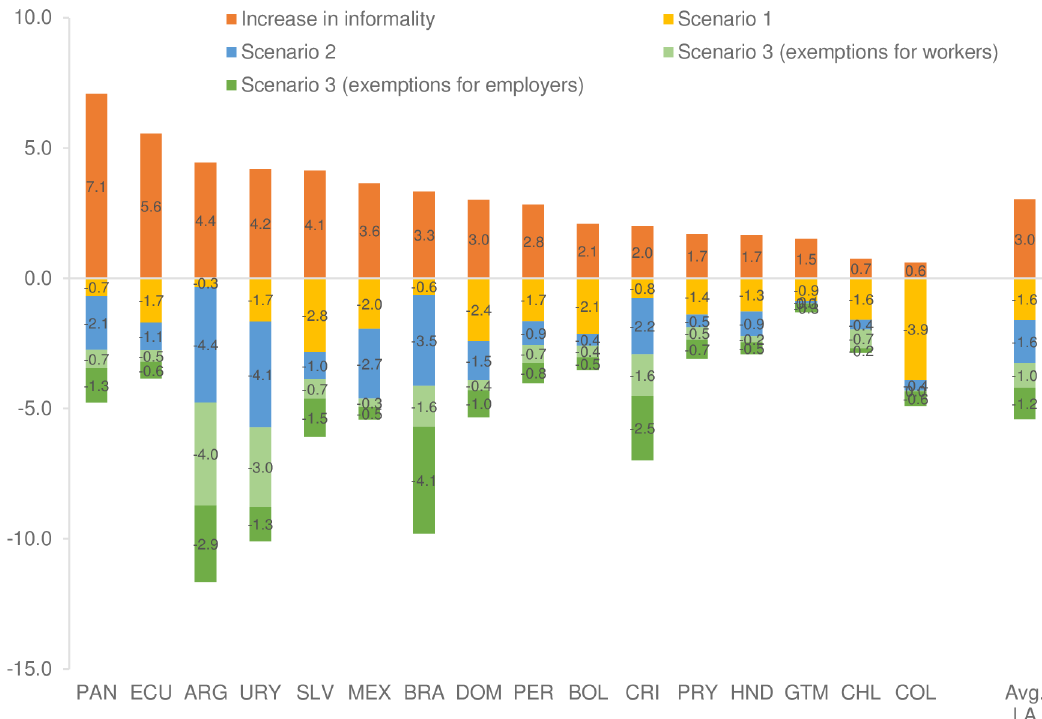
Fig 7. Latin America: Results of the simulation of interventions to cushion impacts on the increase in the informality rate (percentage points). Source: Estimates from household or employment surveys: Argentina—EPH (2019), Bolivia—ECH (2018), Brazil—PNADC (2018), Chile—CASEN (2017), Colombia—GEIH (2018), Costa Rica—ENAHO (2018), Ecuador—ENEMDU (2018), El Salvador—EHPM (2019), Guatemala—ENEI (2018), Honduras—EPHPM—(2018), Mexico—ENIGH (2018), Panama— EPM (2017), Paraguay—EPHC (2018), Peru—ENAHO (2018), Dominican Republic—ENCFT (2017), Uruguay—ECH (2019). p.p.: percentage points. The EPH survey in Argentina only has urban